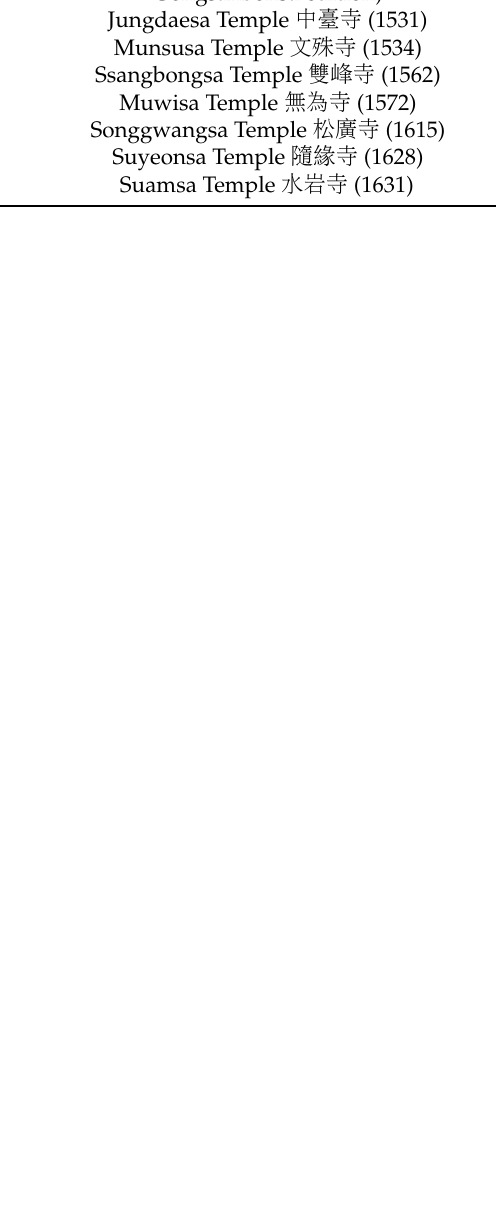
Figure 16. Iconography of the Listener in ( a ) the Lotus Sutra, published at Gongsanbonsa Temple; ( b ) Sakyamuni Preaching from Yeongsusa Temple. Arranged by the